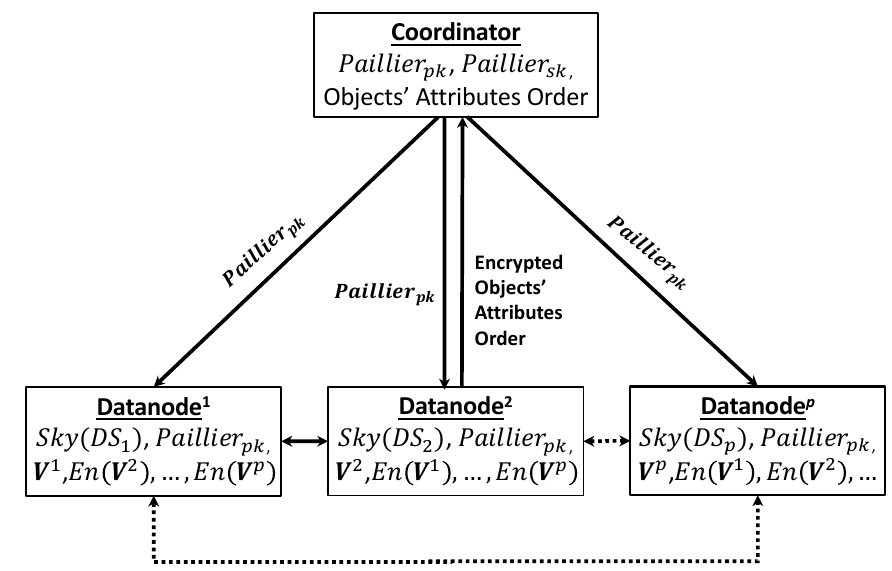
Figure 3. Privacy-preserving multi-party skyline computation